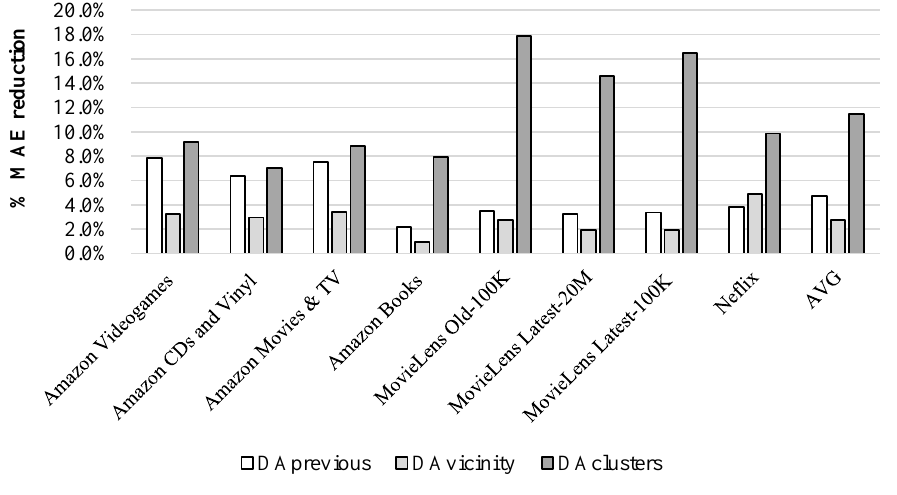
Figure 1. MAE improvement achieved by the DA